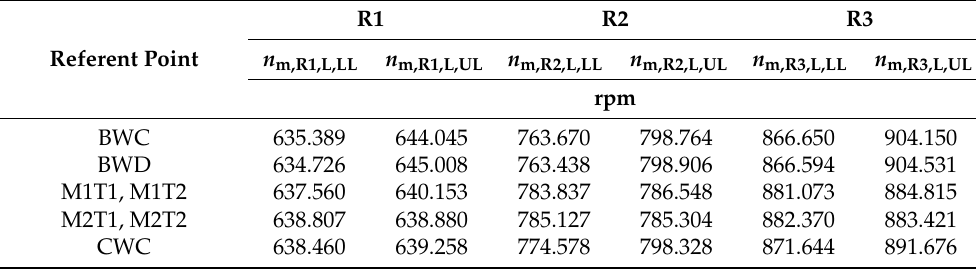
Table 6. Boundaries of the FREM resonant domains according to a L,per –EHO: 1.